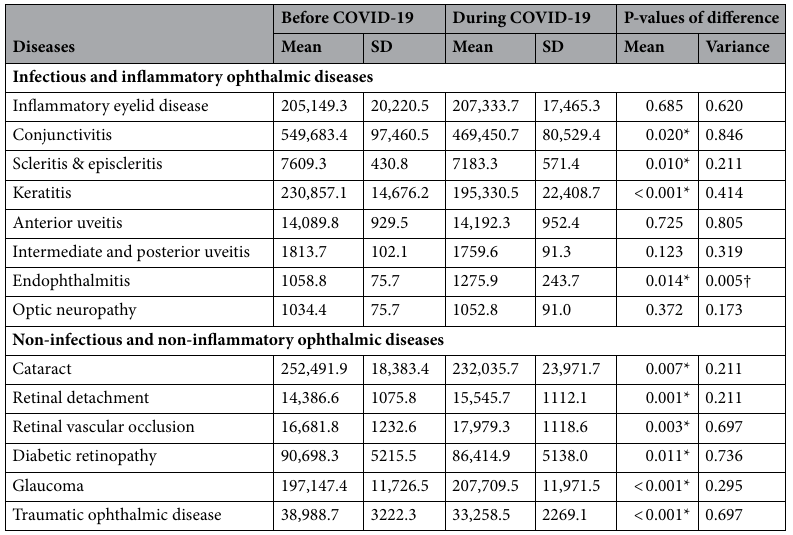
Table 1. Means, standard deviations of disease incidence before and during COVID-19 and their differences. *Mann Whitney U test, significance at < 0.05. †Levene’s test for non-parametric data, significance at <